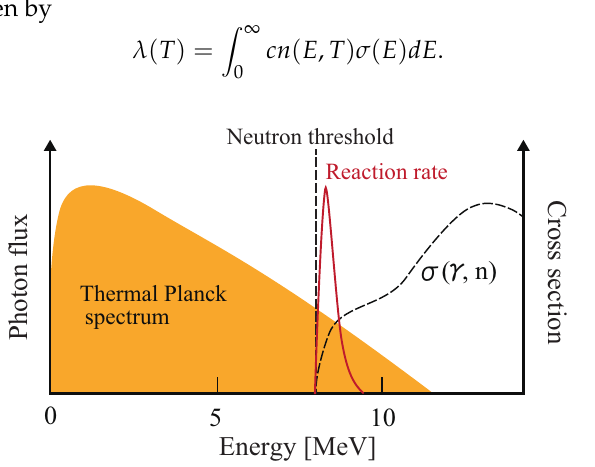
Figure 5. Schematic view of the energy spectrum of photons, photon-induced reaction cross-sections, and reaction rate in hot temperature environments. The filled area shows a typical Planck distribution of photons. The dashed-line shows a typical ( γ , n) reaction cross section. The Y -axis is presented in log scale. The solid line indicates the reaction rate, which simply means flux × cross-section. The concept of this schematic view was adapted from Mohr et al. [21].